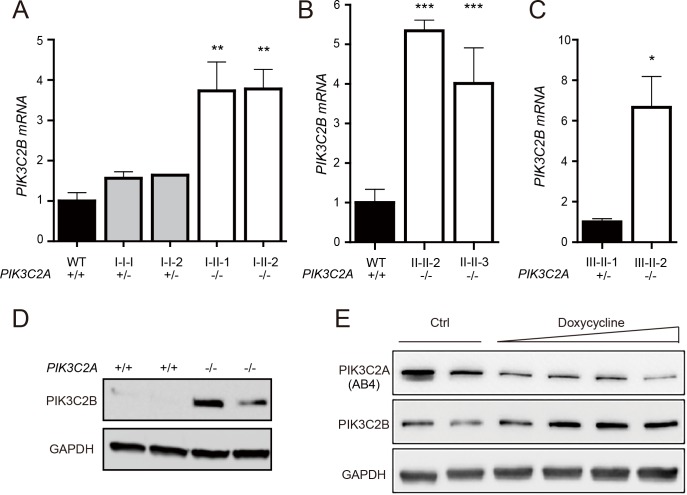
PIK3C2B levels are increased by PIK3C2A deficiency.PIK3C2B mRNA levels were detected by qRT-PCR in (A) Family I, (B) Family II, and (C) Family III. qRT-PCR data is represented as mean ± SEM (n = 3 technical replicates per sample). The WT sample in Fig 6A is based on n = 1 and the WT sample in Fig 6B is based on n = 3, totaling n = 4 different WT samples. (D) PIK3C2B protein levels were detected by Western blotting in Family I from 2 independent experiments. (E) PIK3C2A and PIK3C2B protein levels were analyzed in HeLa cells by Western blotting following doxycycline inducible shRNA mediated knockdown of PIK3C2A. Data shown is representative from 3 independent experiments. * indicates p < 0.05, ** indicates p < 0.01. *** indicates p < 0.0001.